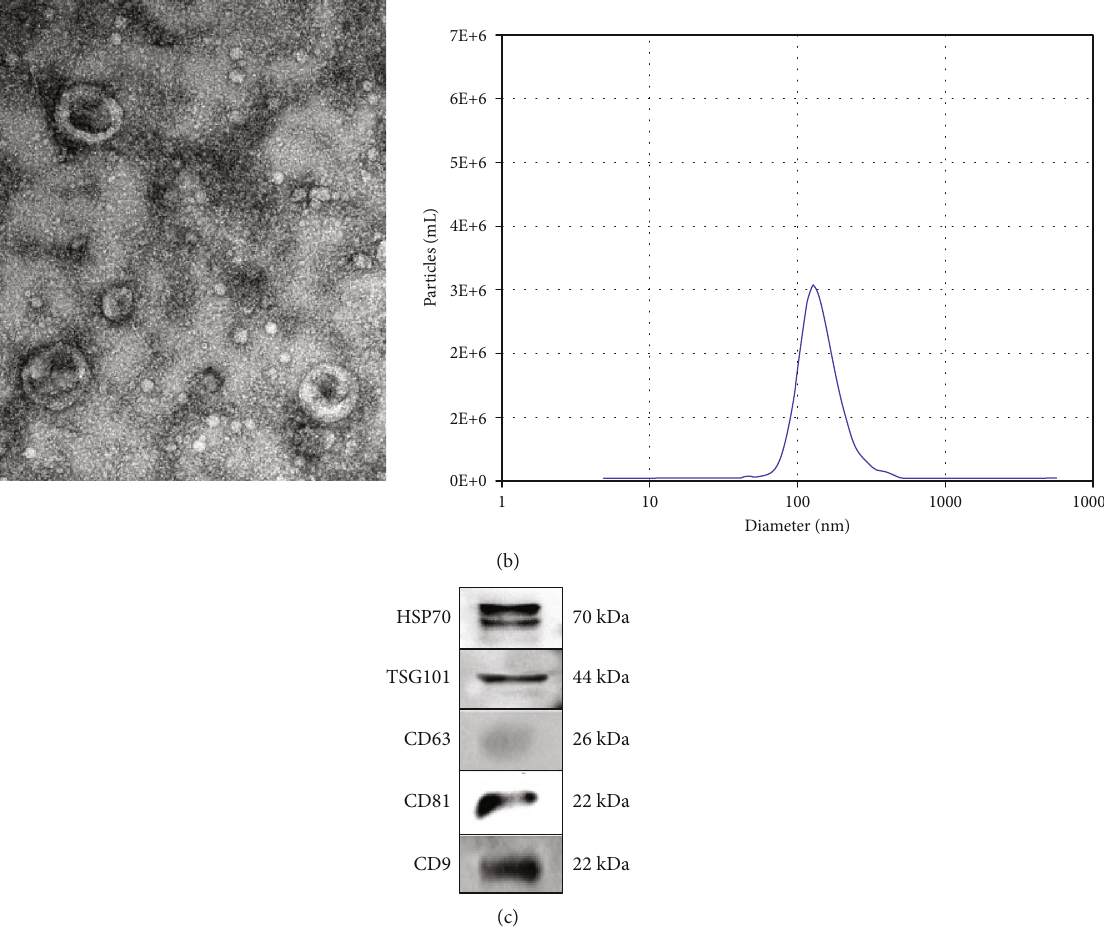
Figure 1: Characterization of PMSC and PMSC EVs. (a) PMSC phenotypes were tested by fl ow cytometry. PMSCs were trypsinized and stained with MSC-related markers CD29, CD90, and CD105 and hematopoietic markers CD45, CD34, and HLA. (b) PMSC-EVs were extracted from cell supernatant. Representative micrograph of puri fi ed PMSC-EVs under transmission electron microscopy showing a cup-shaped membrane vesicle 30-100nm in diameter (30,000 × ). Puri fi ed PMSC EVs particles have a diameter of 100 nm. (c). Expression levels of typical molecular markers of EVs were tested by Western blot including HSP70, TSG101, CD63, CD81, and